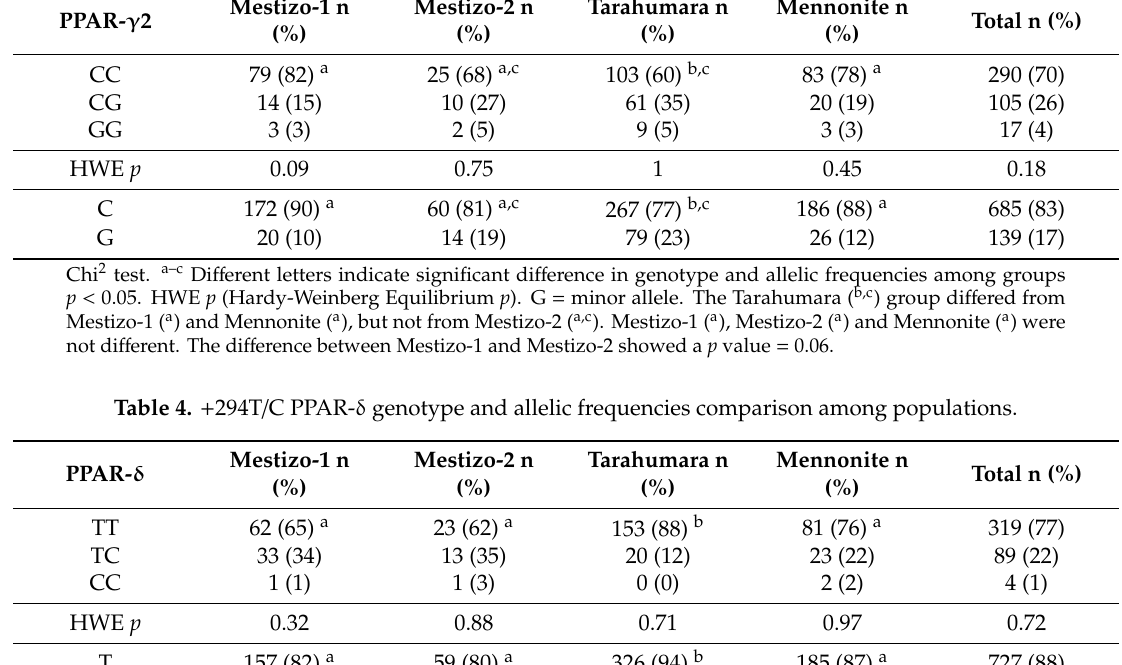
Table 3. Pro12Ala PPAR- γ 2 genotype and allelic frequencies comparison among populations. PPAR- γ 2